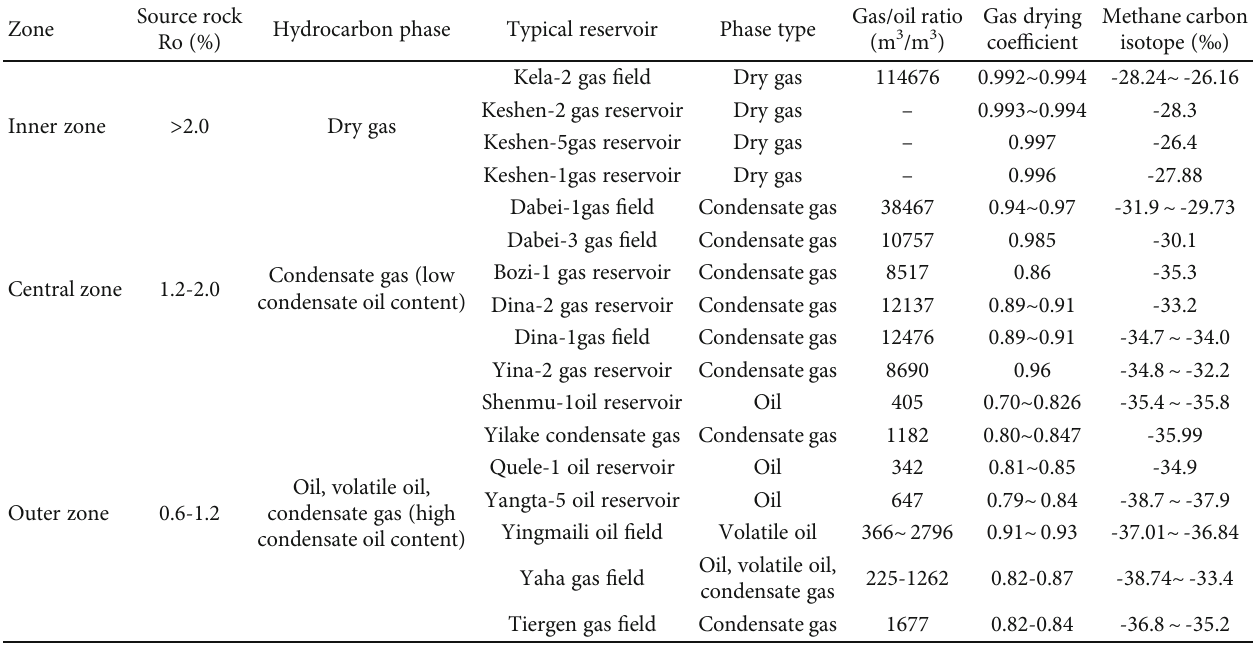
Table 3: Hydrocarbon phases and methane carbon isotope data for di ff erent zones.